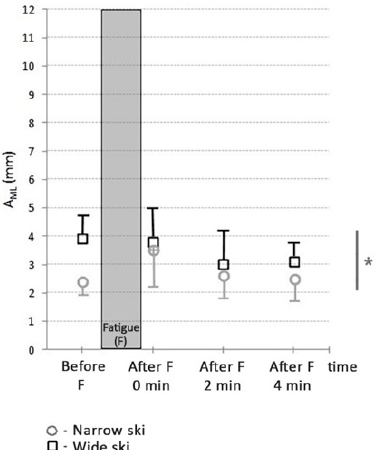
Figure 8. CoP amplitude in mediolateral direction (A ML ) in a prefatigued state (before F) and at different times after fatigue (after F) with two different ski waist-widths. + depicts statistically significant di ff erence compared to prefatigued state ( p < 0.05); * depicts statistically significant di ff erence between all-narrow against all-wide waist-width